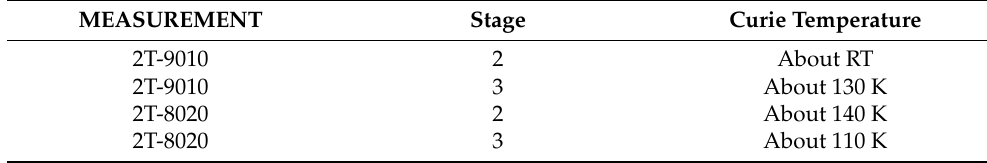
Table A1. Extrapolated possible values for Tc , as resistance maxima in temperature